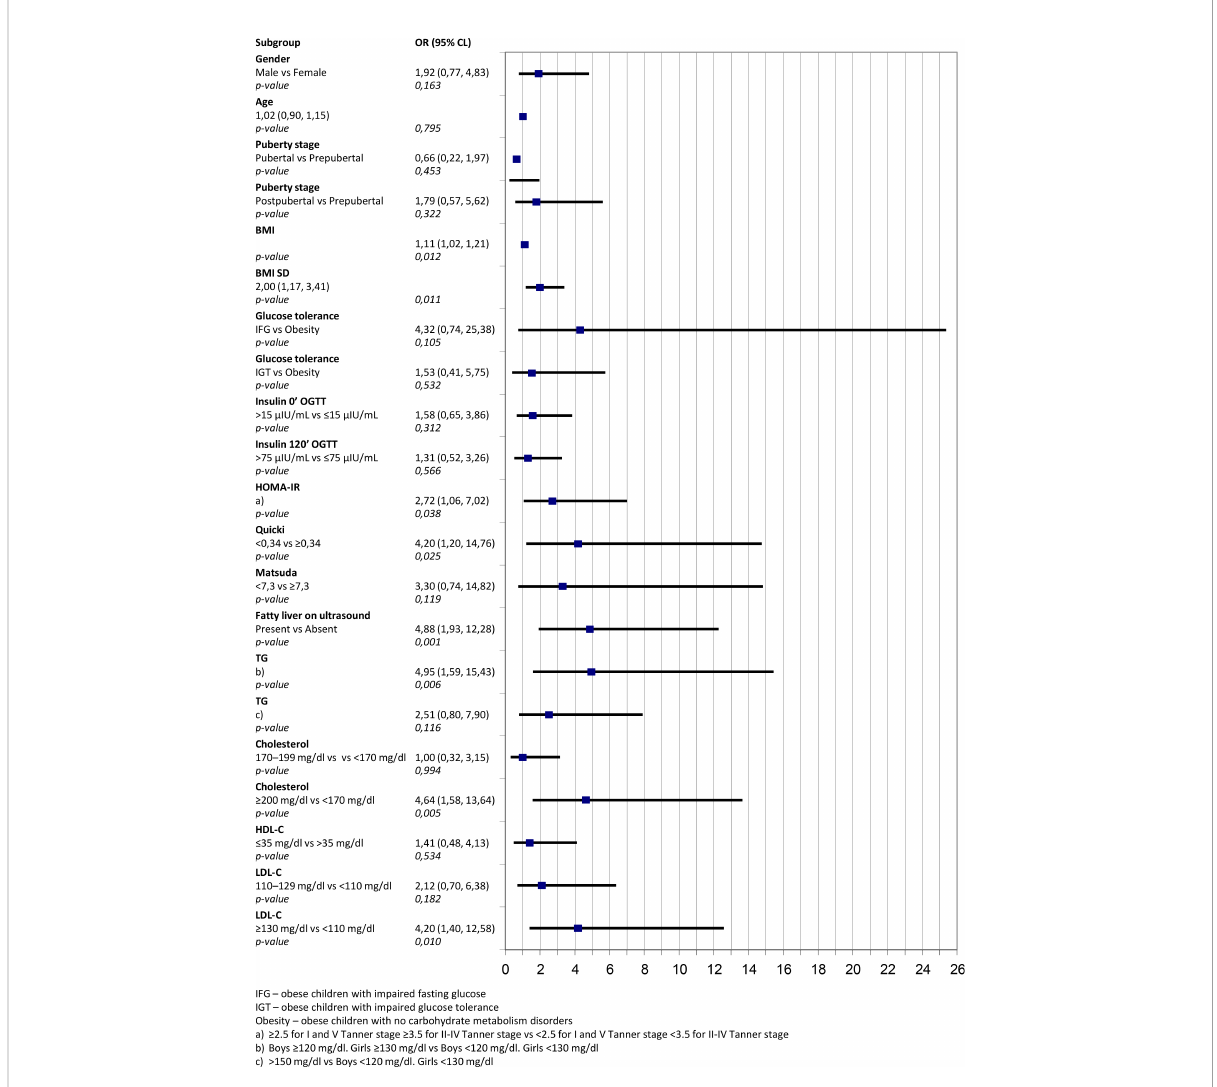
FIGURE 2 Odds ratio for abnormally high levels of alanine aminotransferase for different anthropometrics and biochemical